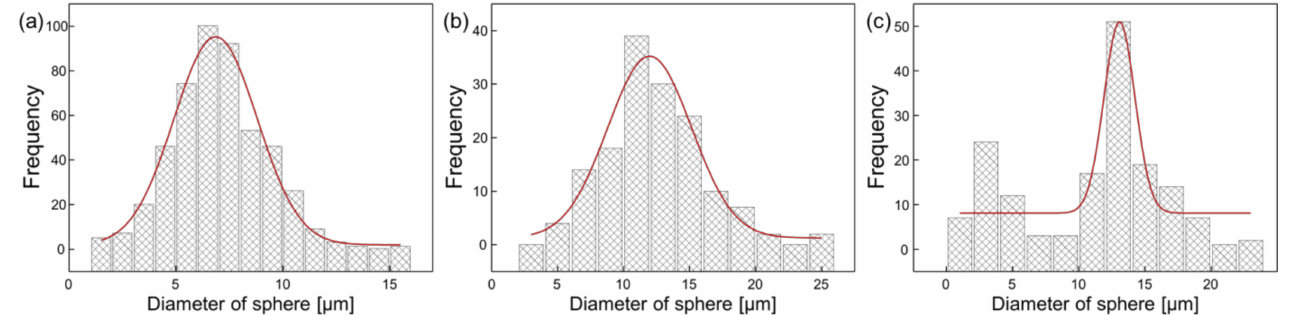
Figure 3. The size distribution of micro-spheres on PDMS film depending on the polymer concen- tration: ( a ) 22.5 mg/mL concentration ( n = 5); ( b ) 45 mg/mL concentration ( n = 5); ( c ) 67.5 mg/mL concentration ( n = 5).